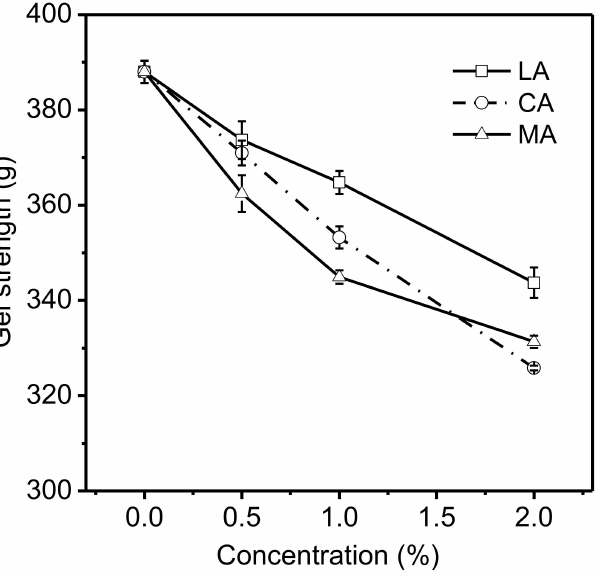
Figure 2. Effects of various concentrations of acids on the strength of 6.67% gelatin